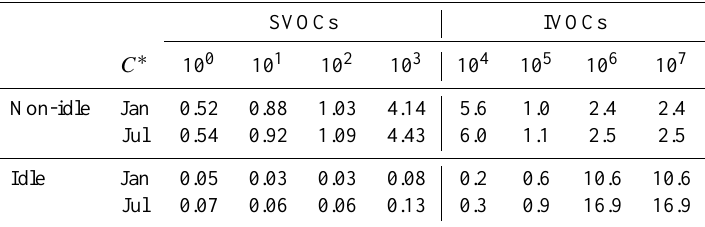
Table 3. Monthly total aircraft emissions (short tons) in January (Jan) and July (Jul) from LTO activities at ATL of SVOCs and IVOCs (non-traditional SOA